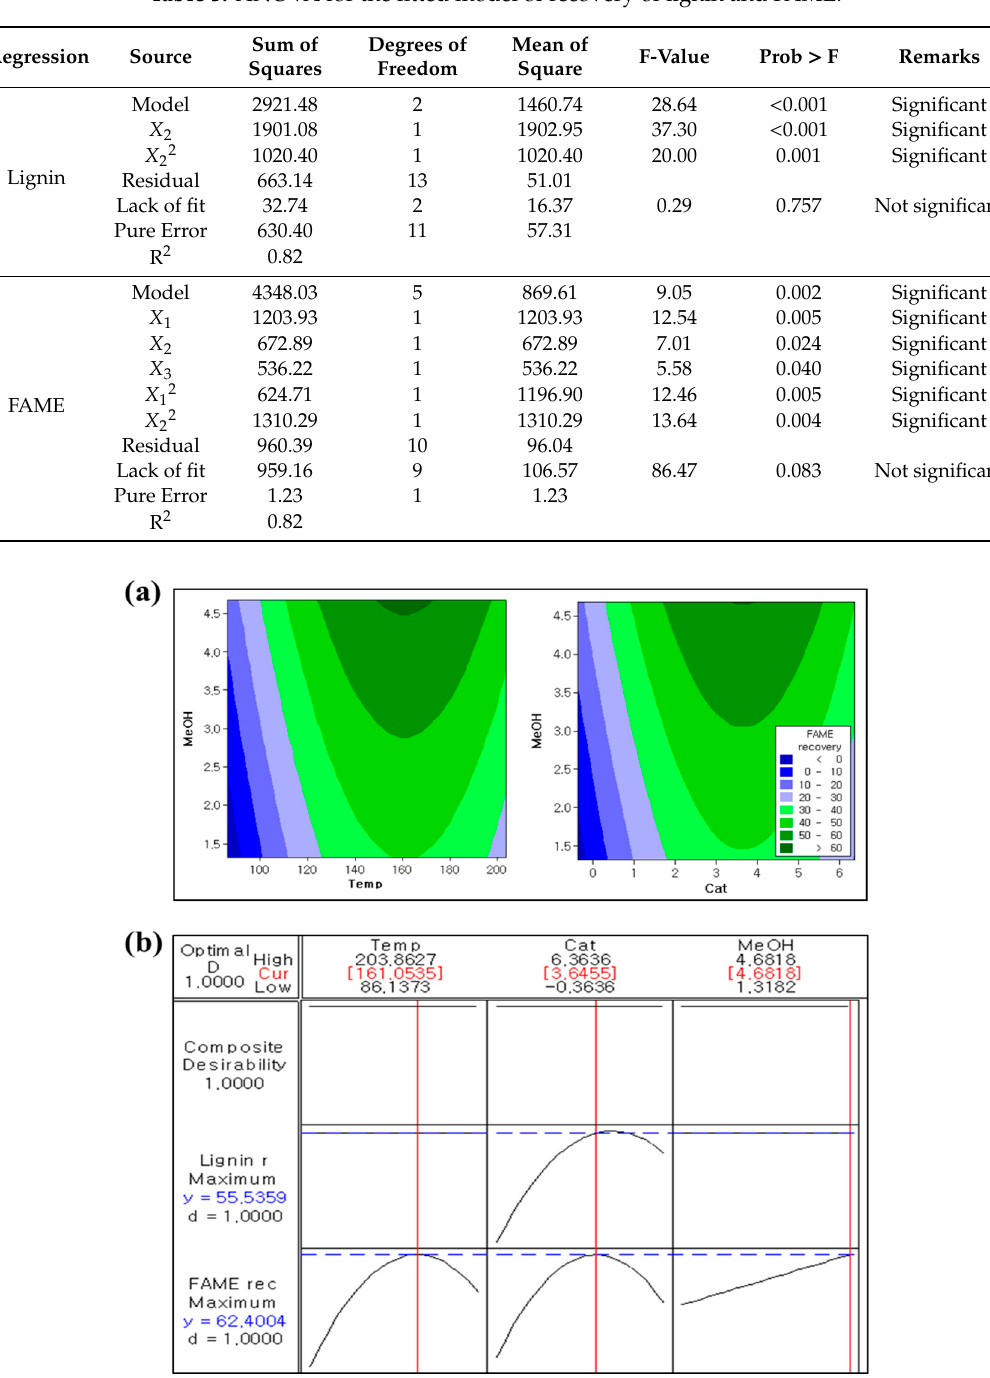
Figure 2. ( a ) 2D contour and ( b ) optimization plot describing the effects of temperature, sulfuric acid concentration and ratio of methanol to SCG on recovery of lignin and FAME from SCG via organosolv treatment. Table 3. ANOVA for the fitted model of recovery of lignin and FAME.